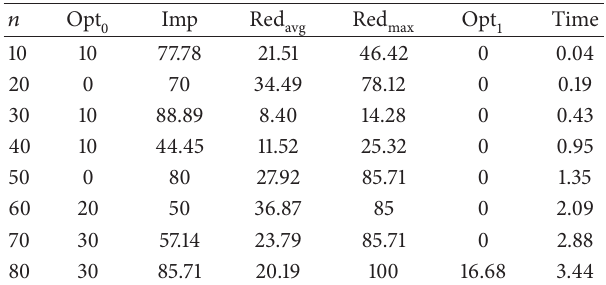
Table 12: Performance of the lower bounds for m =